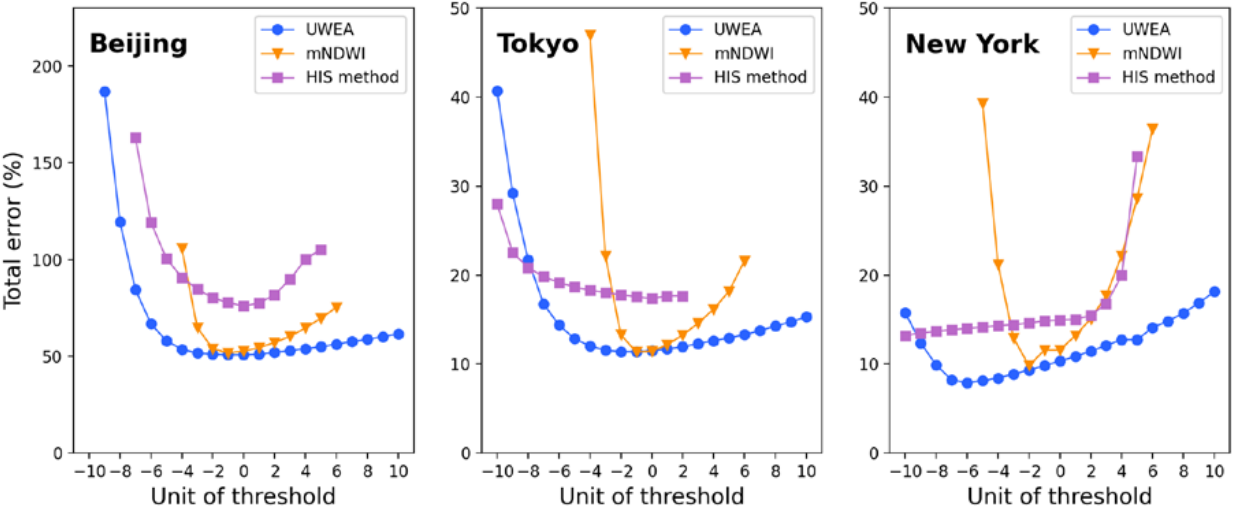
Figure 10. Changes in the total errors of three methods with thresholds for Beijing, Tokyo, and New York. The unit of threshold refers to 0.05 for the UWEA and mNDWI and 10° for the HIS method.